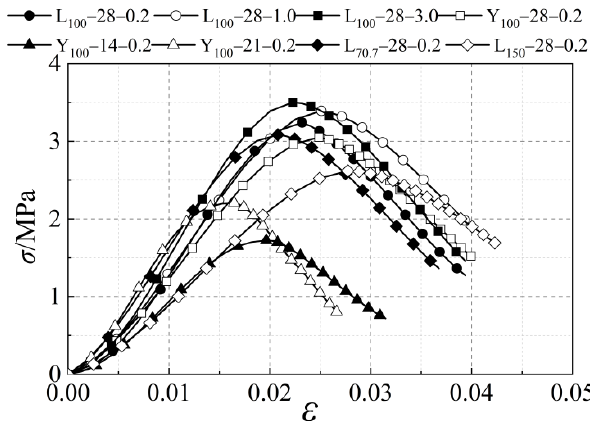
Figure 10. Average stress-strain curves of eight groups of specimens.